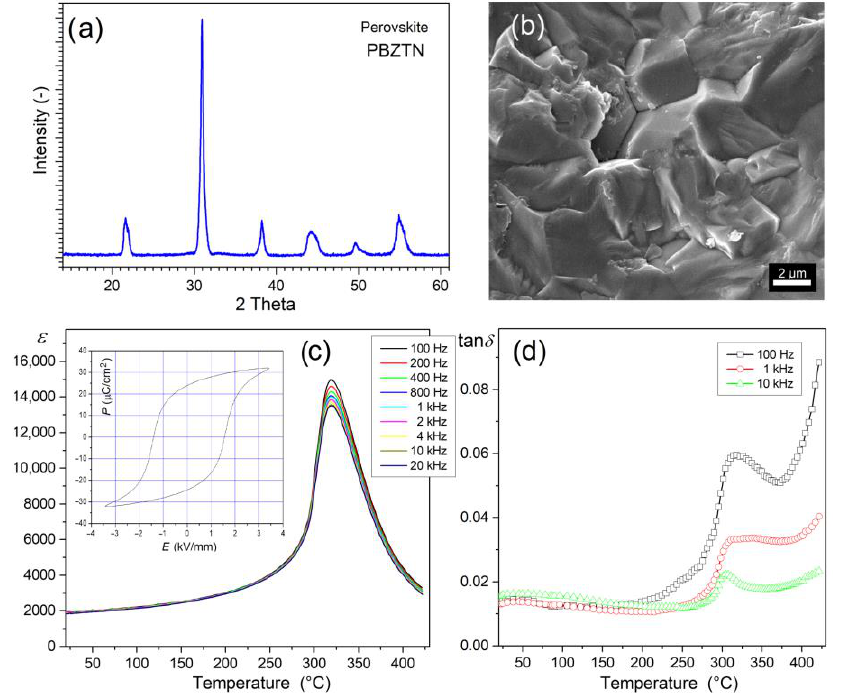
Figure 1. X-ray diffraction ( a ), SEM microstructure ( b ), temperature dependence of permittivity ( c ), and dielectric loss factor (tan δ ) ( d ) for P ceramics. Inside (Figure 1c) ferroelectric hysteresis loop.